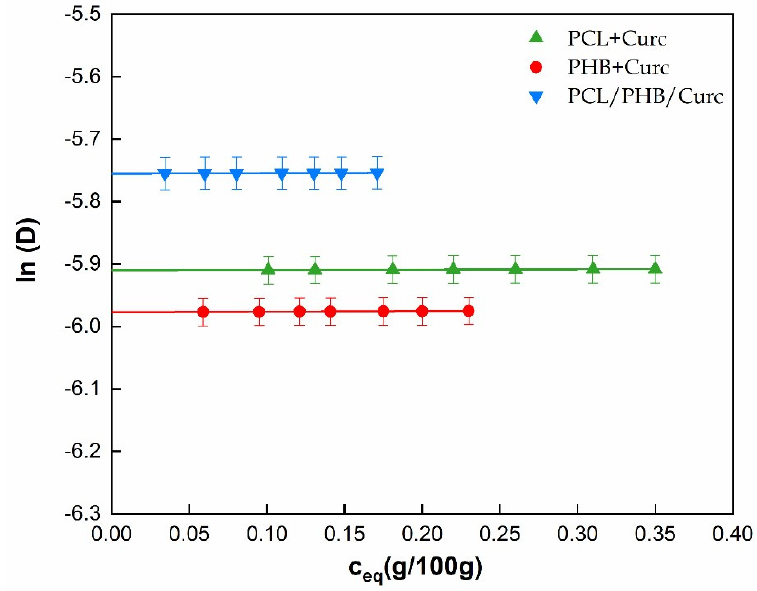
Figure 9. ln (D) as function of equilibrium moisture content Ceq (g/100 g).